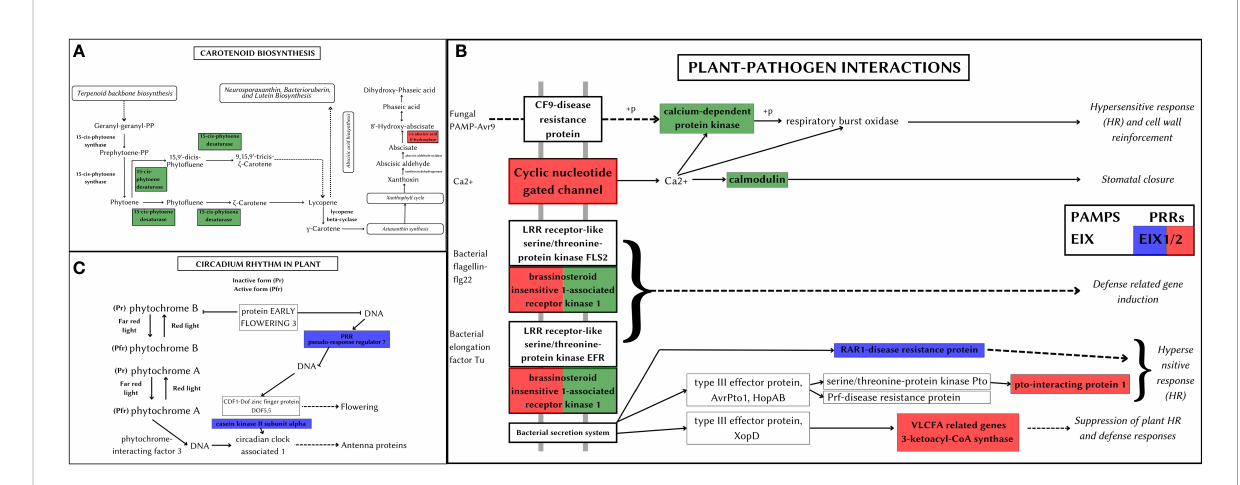
FIGURE 8 Metabolic pathways depicting positively selected genes in Artocarpus species. The positively selected genes in A. hirsutus (green), A. heterophyllus (blue), and A. altilis (red). (A) Carotenoid biosynthesis. (B) Plant-pathogen interactions. (C) Circadian rhythm in